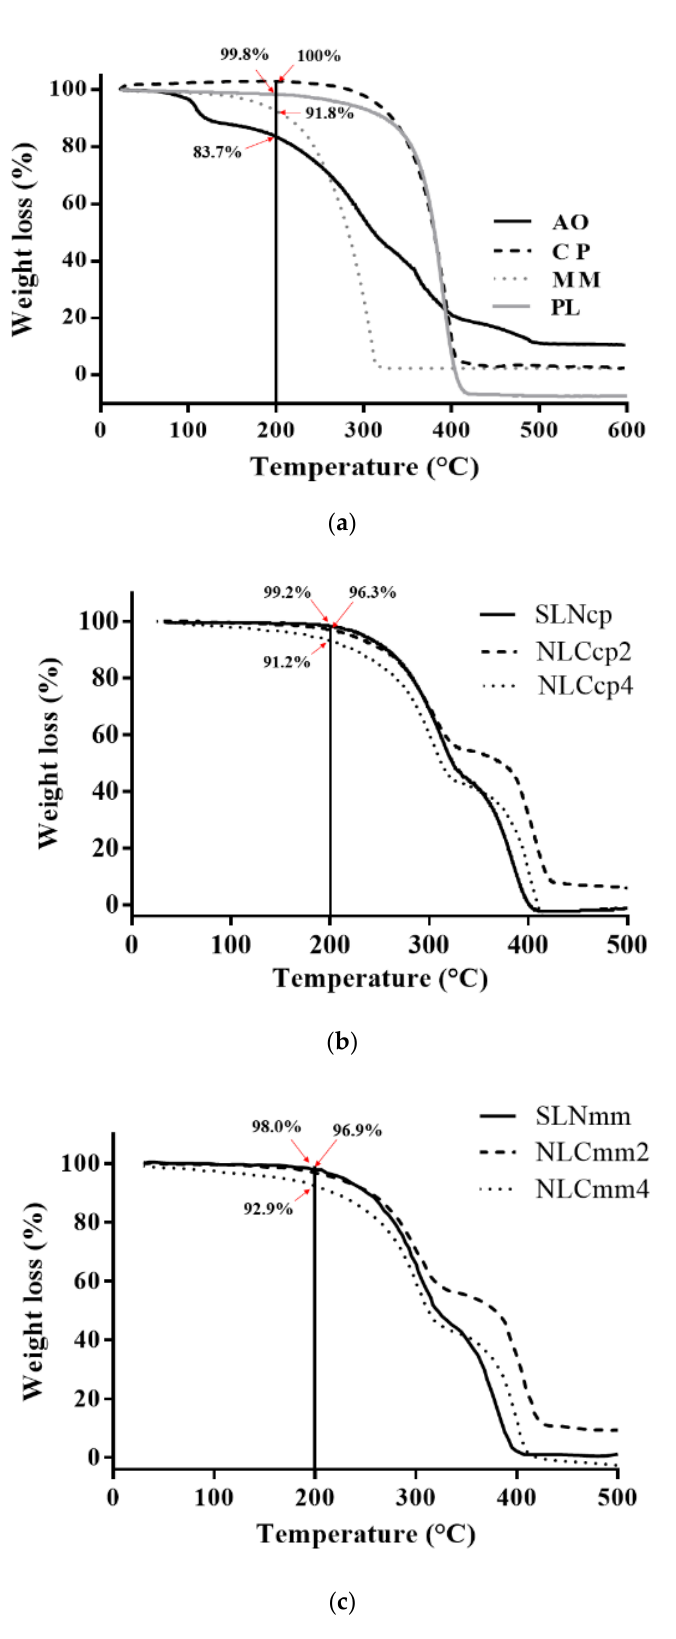
Figure 4. Thermogravimetry analyses of pristine compounds ( a ), cetyl palmitate-based nanoparticles ( b ), and myristyl myristate based nanoparticles ( c ).